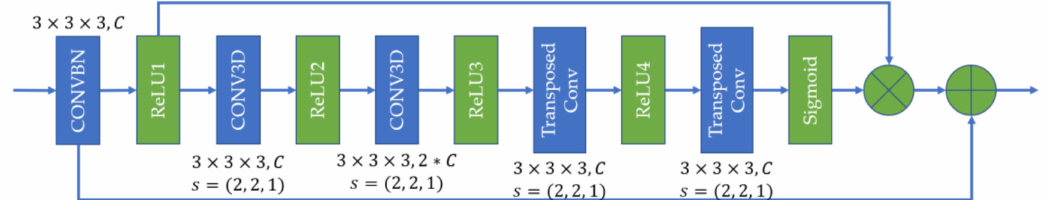
Figure 7. The structure of the residual spatial-wise attention (RSA)